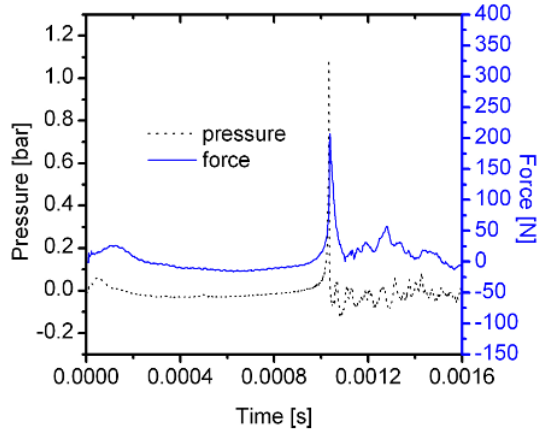
Fig. 4. Collapse pattern 1 – hydrophone and PVDF film signals.